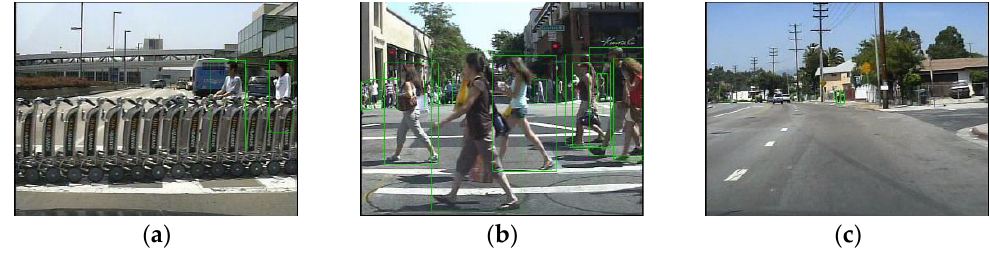
Figure 1. ( a ) is a case where the pedestrian is partially occluded. ( b ) is a case where there are many pedestrians in a frame of image. ( c ) is a case where the pedestrian has a quite small size or long distance. These images and ground truth bounding boxes are from the Caltech–Zhang pedestrian dataset.